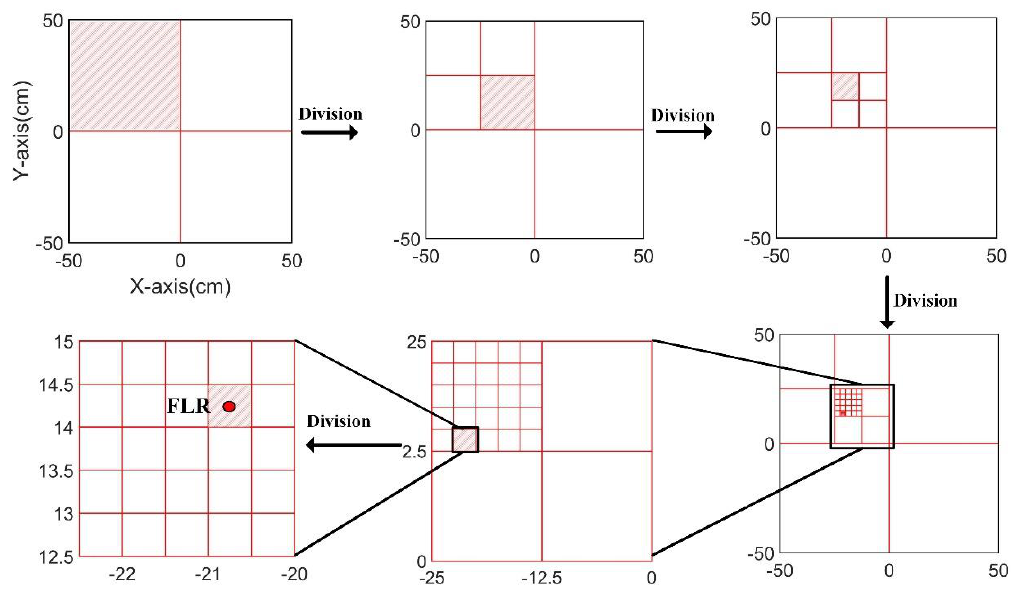
Figure 11. Procedure of the posterior probability location results optimization (PPLSO) algorithm.